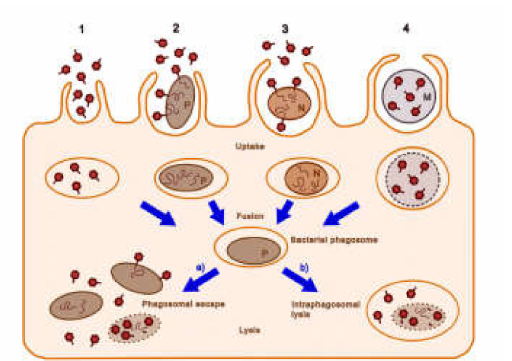
Figure 3. Possible cellular entry pathways of bacteriophages. The pathways 1–4 are described in the text. Dark red hexagons, bacteriophage; brown-filled ovals, bacteria (pathogenic bacteria, P; non-pathogenic bacteria, N); curly lines within bacteria, bacteriophage nucleic acids; orange ovals, endosomal vesicles; blue-gray circles and M, microcapsules; dotted lines, degrading bacterial membrane (reproduced with permission from Nieth et al., 2015